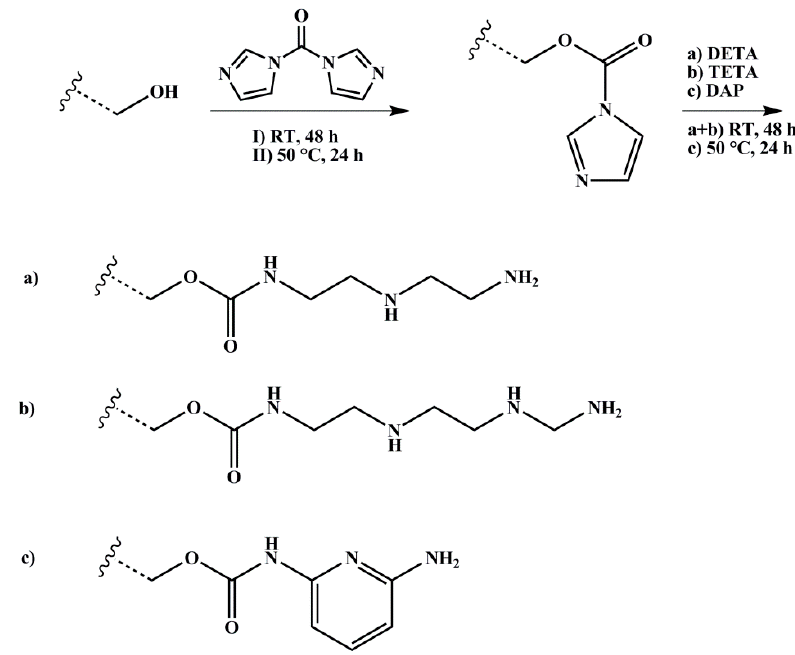
Figure 5. Reaction scheme for amination of hydroxylated polymers with different amines (DETA: diethylenetriamine, TETA: triethylenetetramine, DAP: 2,6-diaminopyridine) with 1,1’-carbonyldiimidazole (CDI) as coupling agent. Wavy lines represent the polymeric main chain.